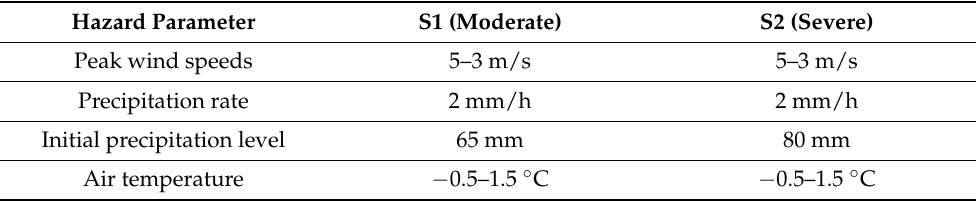
Table 1. Expected values for parameters characterizing wet snow